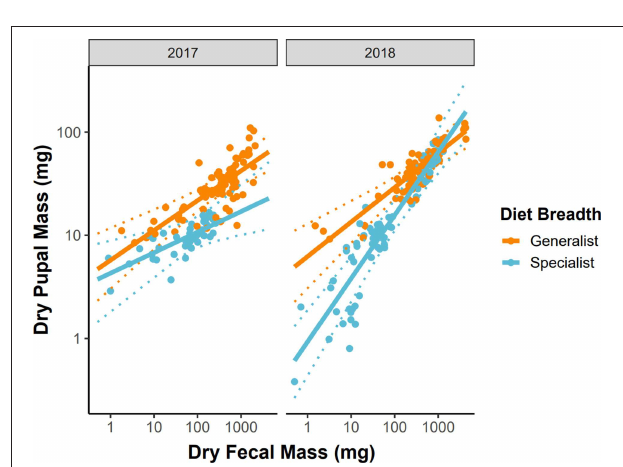
FIGURE 4 | Growth efficiency across years for dietary specialist and generalist subsets of the caterpillar community. Variation in the slope of these relationships indicates variation in growth efficiency between dietary specialist and generalist caterpillars. Solid lines represent the predicted values from LMMs, dashed lines represent 95% confidence intervals around the predictions, and points are the raw data reshaped to account for the random effects of caterpillar